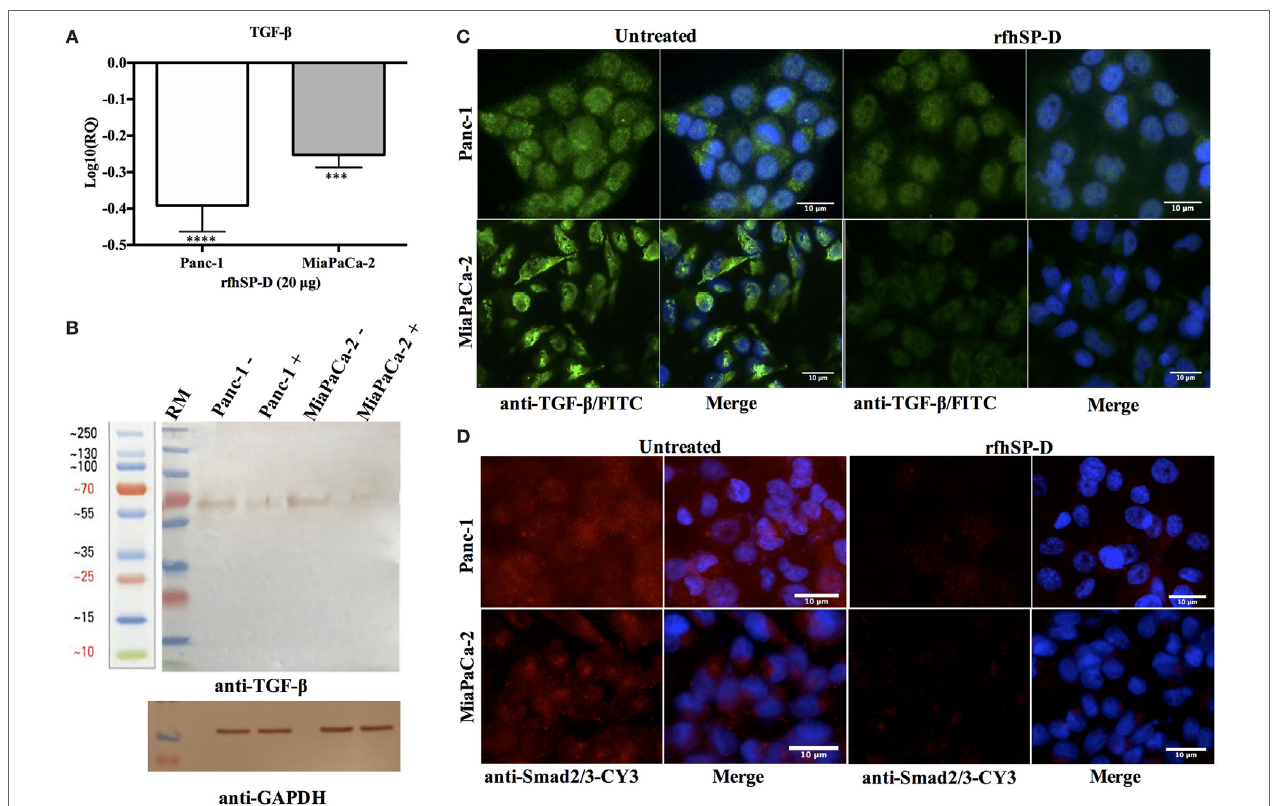
FigUre 5 | Treatment with rfhSP-D downregulates TGF- β expression. (a) TGF- β gene expression, as determined by qPCR, was significantly downregulated at 12 h in both Panc-1 and MiaPaCa-2 cell lines. Significant values were considered based on *** p < 0.001 and **** p < 0.0001 between treated and untreated samples. (b) Western blot analysis revealed a ~60 kDa band that was very faint in the rfhSP-D-treated sample. (c) TGF- β intracellular staining for cell lines. 0.5 × 10 5 cells were incubated with and without rfhSP-D (20 µg/ml) for 24 h followed by probing with rabbit anti-human TGF- β 1 antibody (1:500), and then by Alexa Fluor 488 (1:500) and Hoechst (1:10,000). Immunofluorescence analysis showed bright green fluorescence in the cytoplasm of the untreated cells as compared to weak staining in the treated cells. (D) Smad 2/3 intracellular staining for Panc-1 and MiaPaCa-2 cell lines with and without rfhSP-D (20 µg/ml) treatment for 24 h using rabbit anti-human Smad2/3 antibody (1:500) and then probed with anti-rabbit CY3 (1:1,000) showed the presence of Smad2/3 in the cytoplasm of untreated cells; however, no CY3 fluorescence was detected in the rfhSP-D-treated